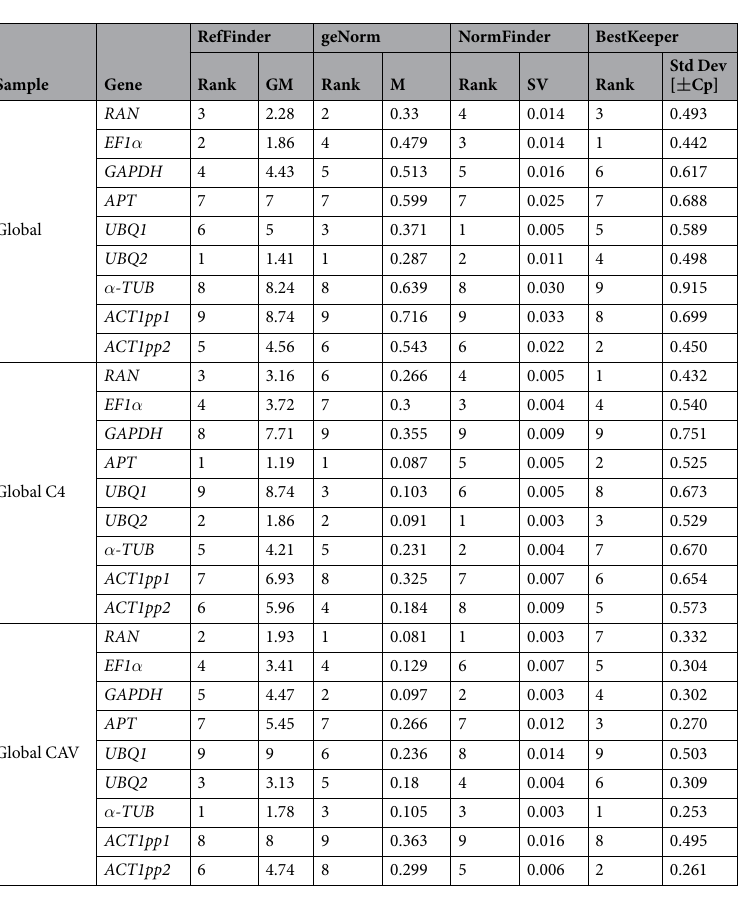
Table 2. Expression stability analysis of each candidate reference gene for Musa acuminata leaf tissues based on algorithms geNorm, NormFinder and BestKeeper. Overall re-ranking was performed using RefFinder. GM, Geometric Mean; M, Average expression stability; SV, Stability Value; Std Dev, Standard Deviation; Cp, Process Capability. With NormFinder and geNorm, low stability values indicate greater gene expression stability. With BestKeeper, genes with standard deviation values greater than 1 are considered as